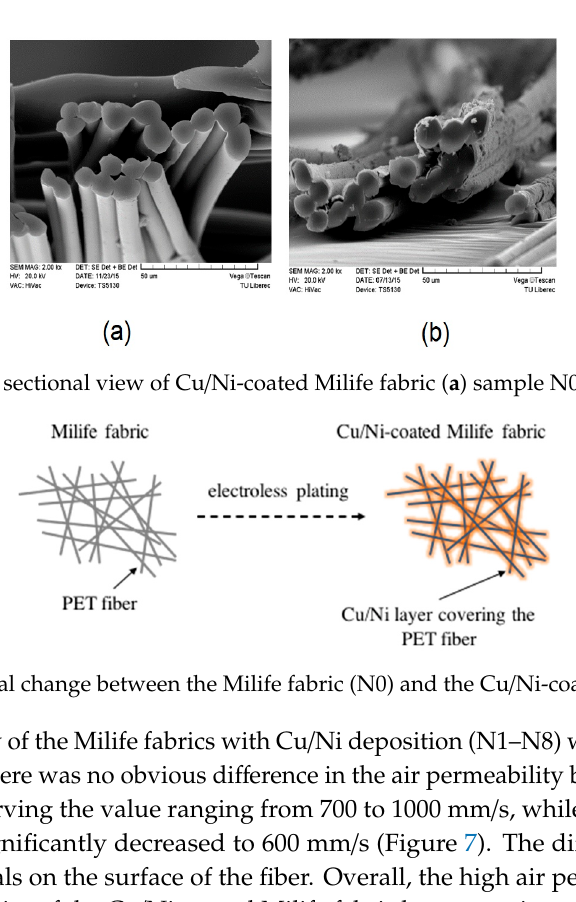
Figure 6. Structural change between the Milife fabric (N0) and the Cu/Ni-coated Milife fabric.